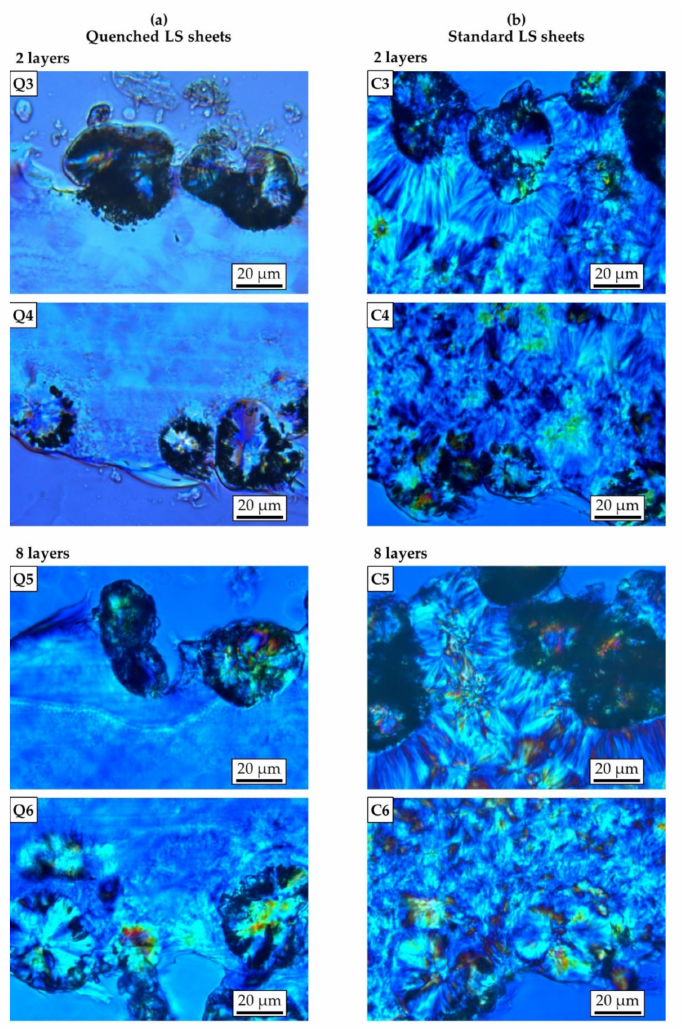
Figure 4. Light microscopy images of thin sections showing the top and bottom surfaces of ( a ) quenched and ( b ) standard laser-sintered (LS) polyamide 12 sheets generated with two and eight layers. Regarding the standard LS sheets, the microscopic images show that the LS sheet produced with eight layers exhibits significantly larger spherulites compared to the LS sheet consisting of two layers (Figure 3, C1 and C2). The different degree of melting of the polymer, accompanied by the influence of different temperature gradients, could have led to a different crystalline structure upon cooling [29]. Independent of the thickness, crystallization seems to be less developed in the near surface region on the bottom side of the standard LS sheets (Figure 4, C4 and C6). The effect might be explained by a low temperature in the melt and fast cooling of the polymer in the first layer. By contrast, there are large lamellae surrounding the powder particles adhering to the top surfaces of the standard LS sheets (Figure 4, C3 and C5). This is in good agreement with earlier research demonstrating that cool particles introduced into the melt during powder coating could act as crystallization nuclei